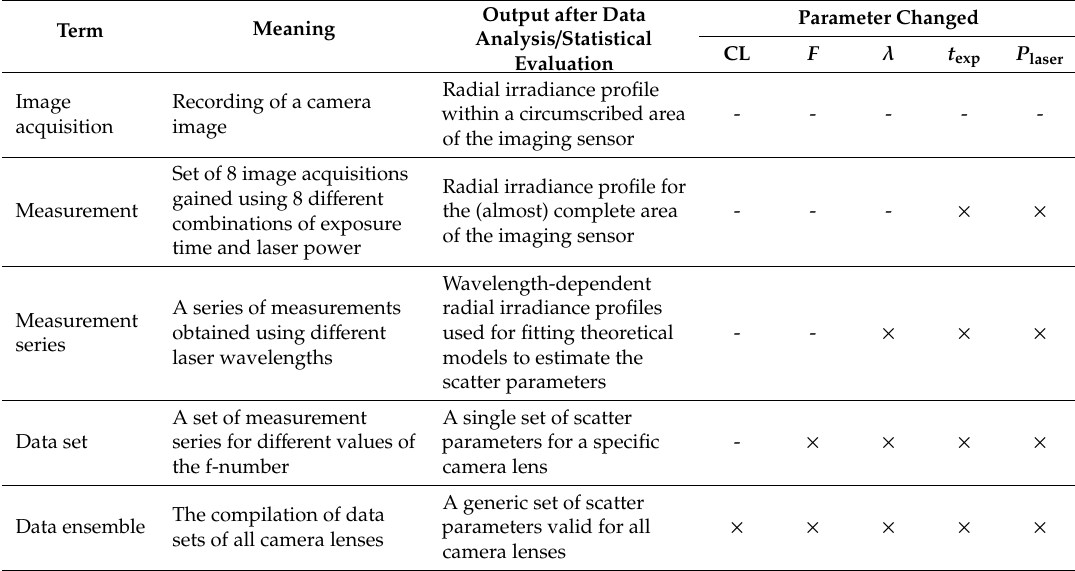
Table 4. Combinations of exposure time t exp and nominal optical density OD A2 of attenuator A2.